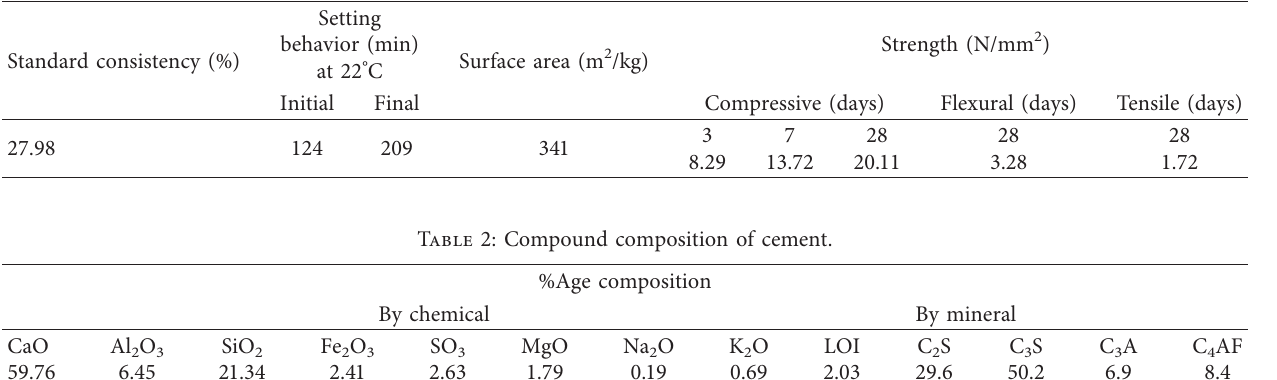
Table 1: Properties of cement.